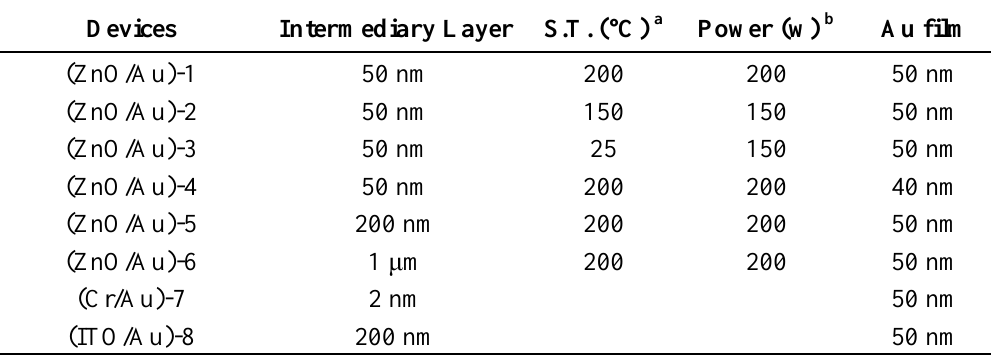
Table 1. Fabrication parameters for the eight